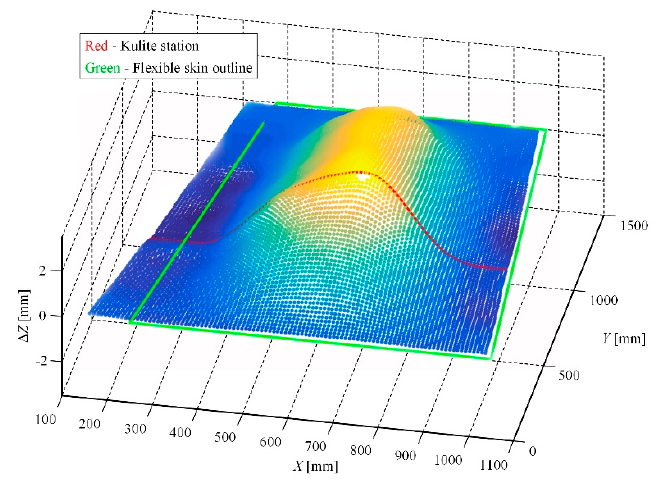
Figure 15. Laser scan of the morphed wing shape for the M = 0.2, α = 2 ◦ , and δ = 4 ◦ flow case.